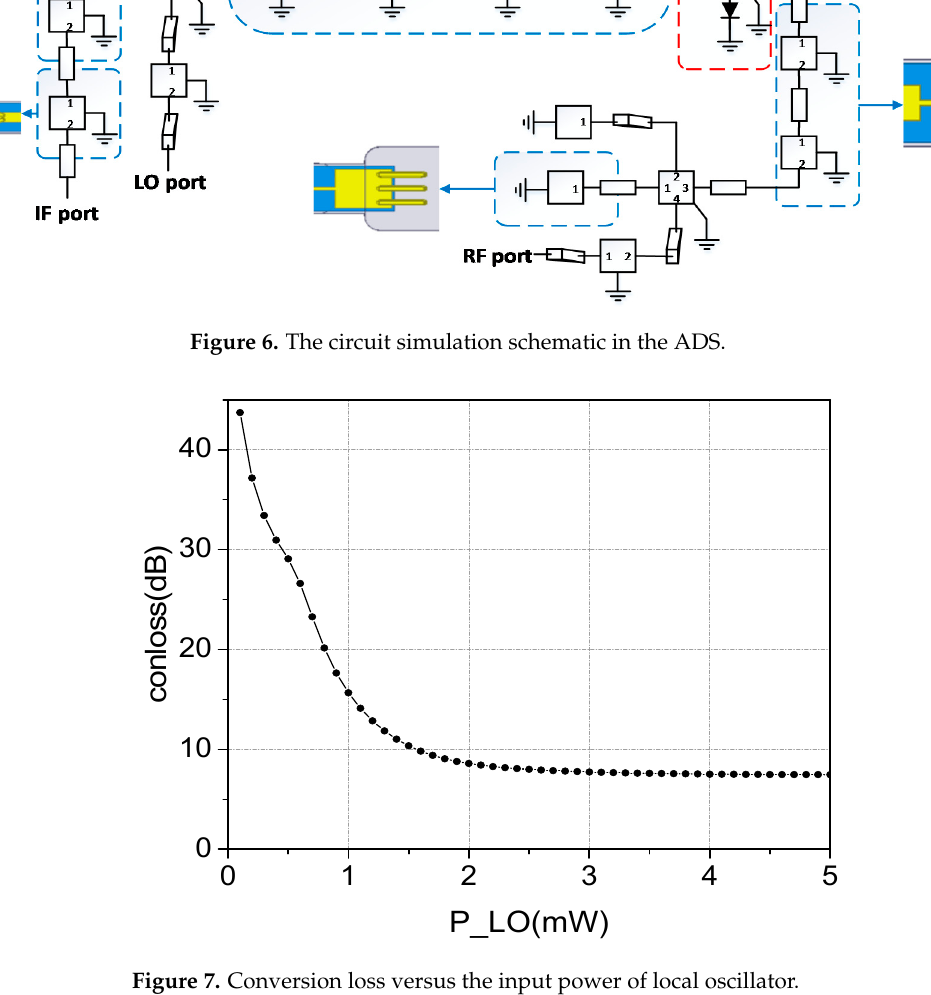
Figure 7. Conversion loss versus the input power of local oscillator.